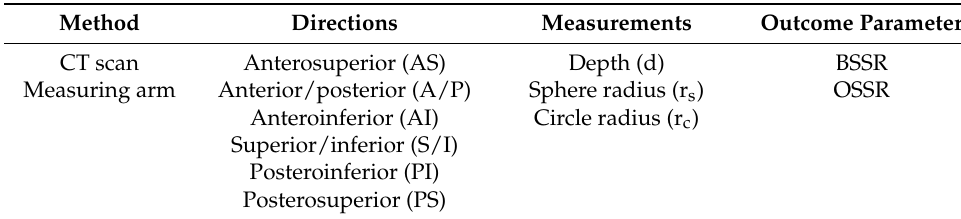
Table 1. Summary of methods, directions, measurements, and outcome parameters.